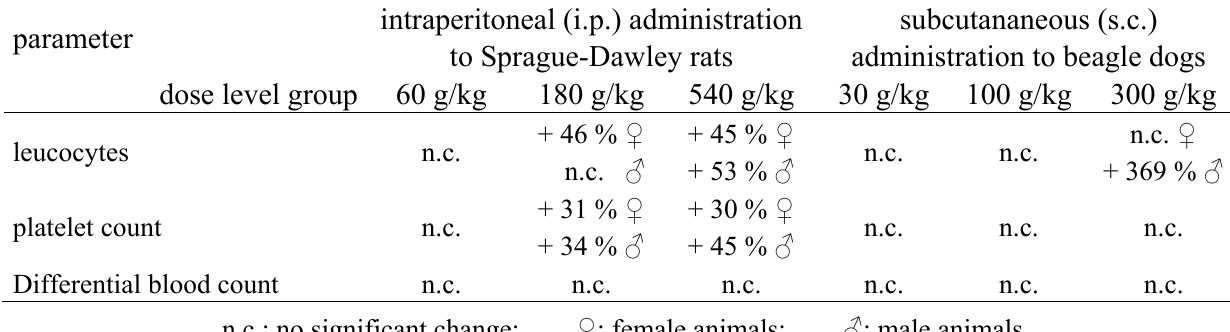
Table 1 . Examinations after 28 days of daily TE administration within subchronic toxicity studies in comparison to the parallel administration of